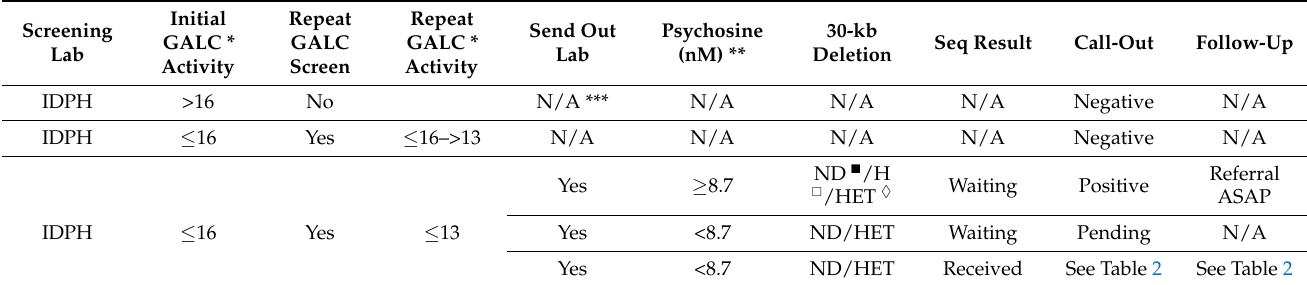
Table 1. GALC screening, analytical and post-analytical workflow and initial reporting for KD at IDPH. Screening Lab